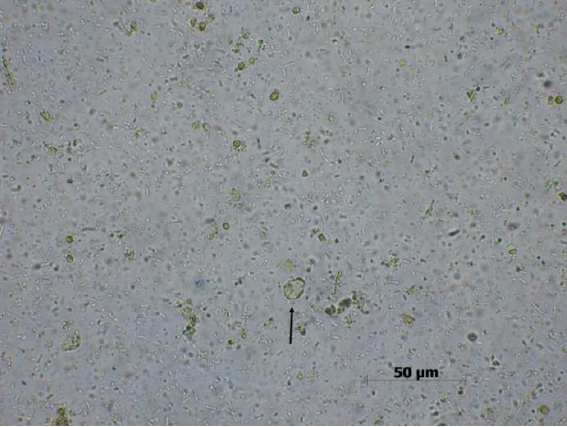
Figure 4. Blastocystis hominis vacuolar forms found in a wet mount sample at 40x magnitude (original photography).